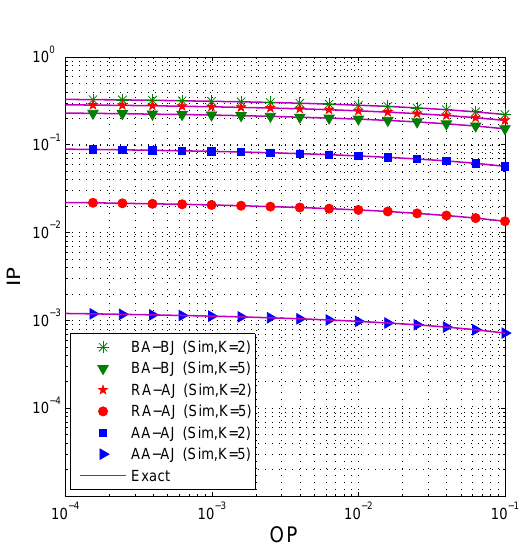
Figure 8. IP as a function of K when ∆ = 5 (dB), C N T = 2 , α = 0 . 1 , K = 4 , M = 5 and µ 2